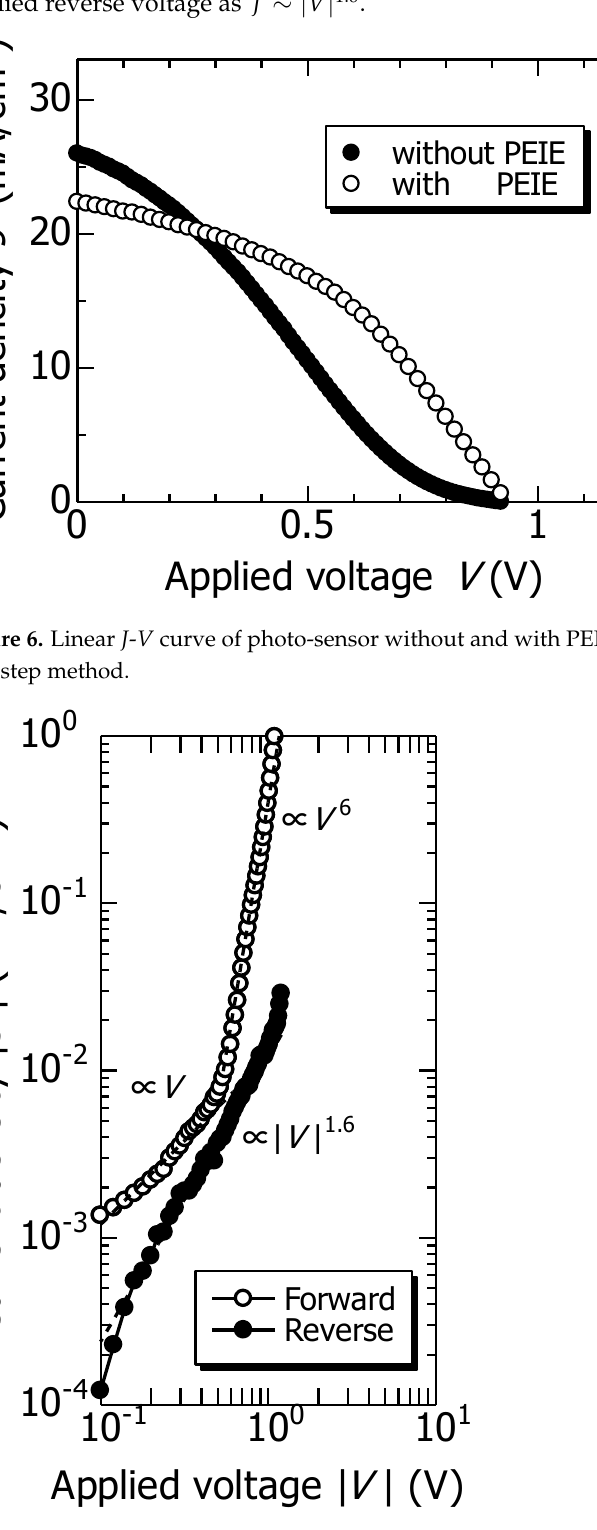
Figure 7. Logarithm plot of current density vs. voltage characteristics in FTO/TiO 2 /PEIE/two-step perovskite/Spiro-OMeTAD/Au structure under dark condition.